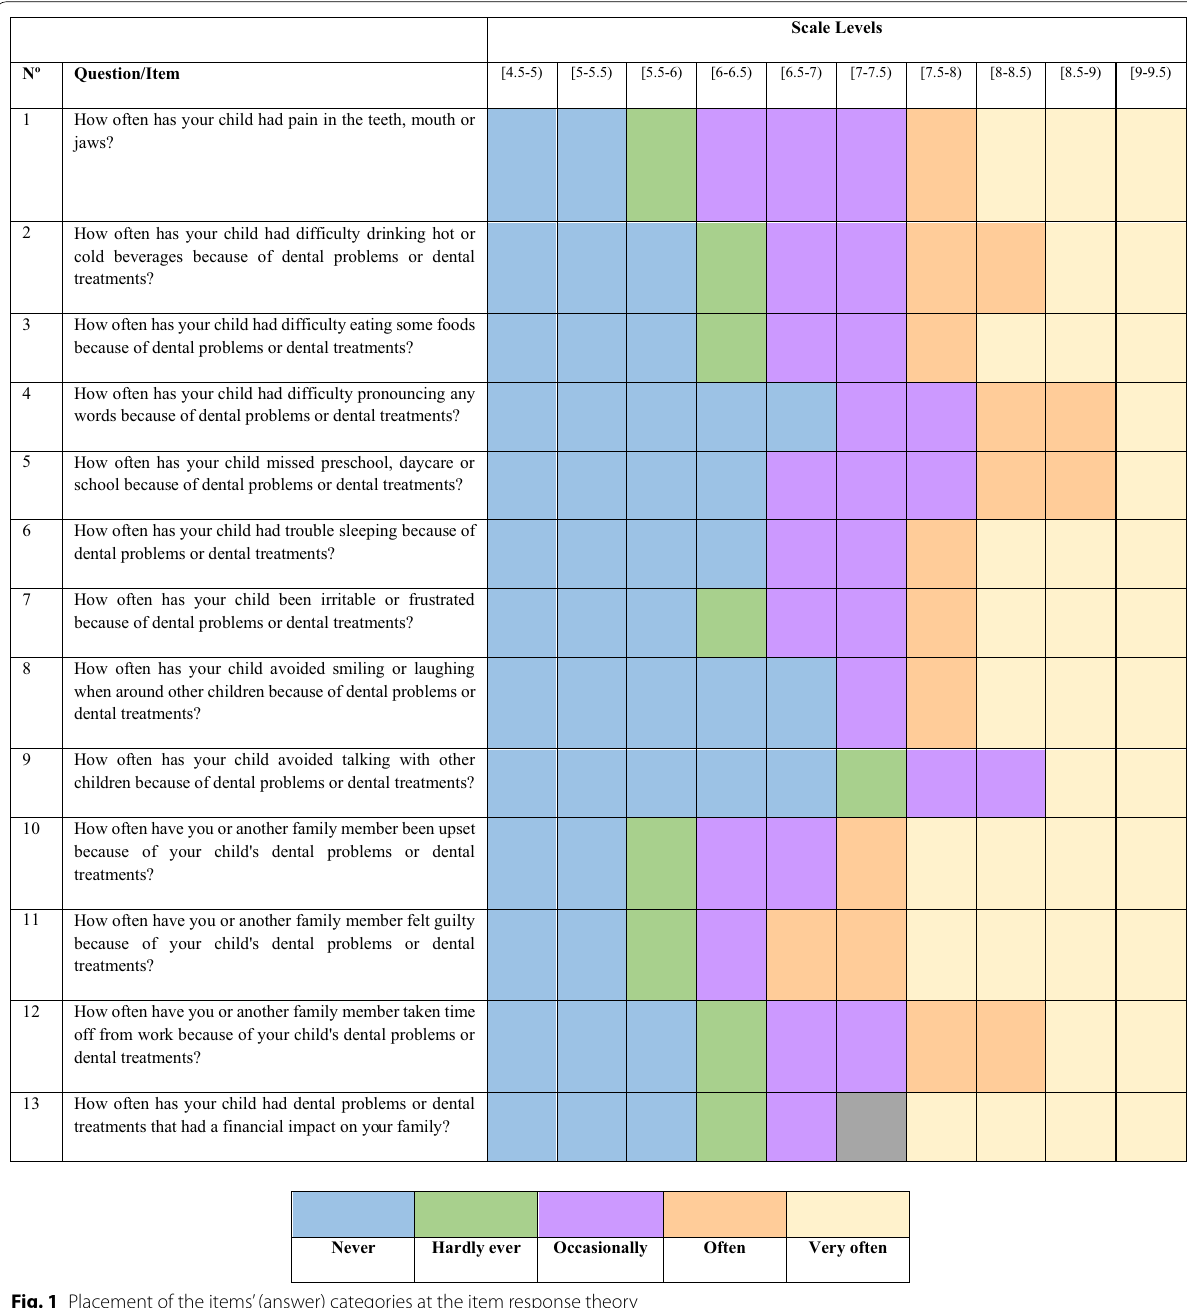
Fig. 1 Placement of the items’ (answer) categories at the item response